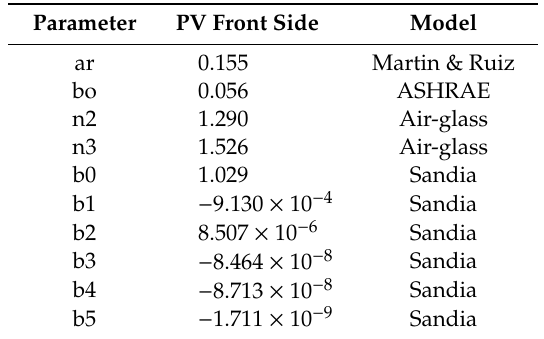
Table A2. Incident angle modifier coe ffi cients used in simulations. All model coe ffi cients—Except for the Physical model—Were extracted using a Gauss-Newton fitting algorithm and an IAM curve of a PV module with anti-reflective coating.